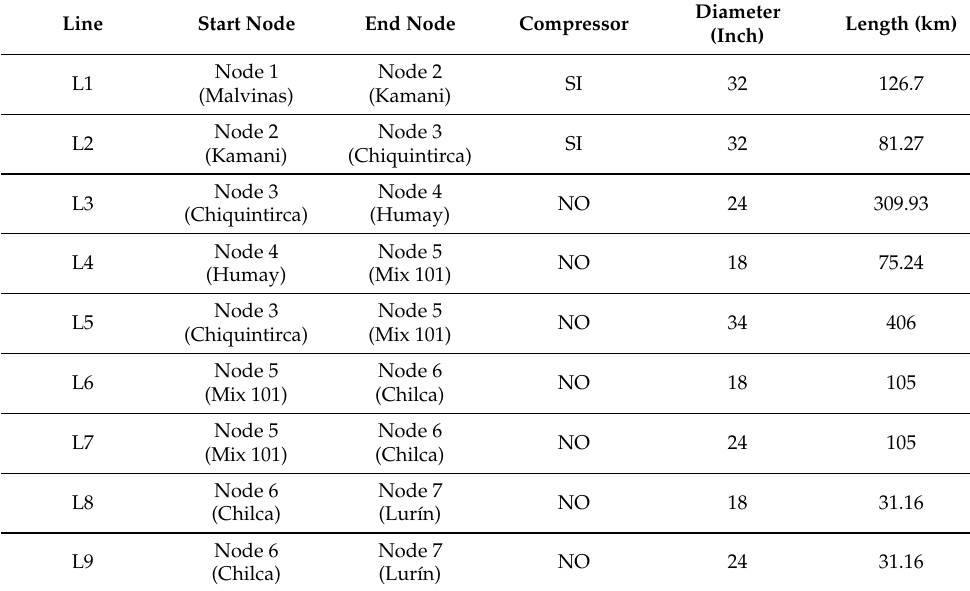
Table 5. Lengths of the main network, including the diameter of the pipeline (adapted from Osin- ergmin